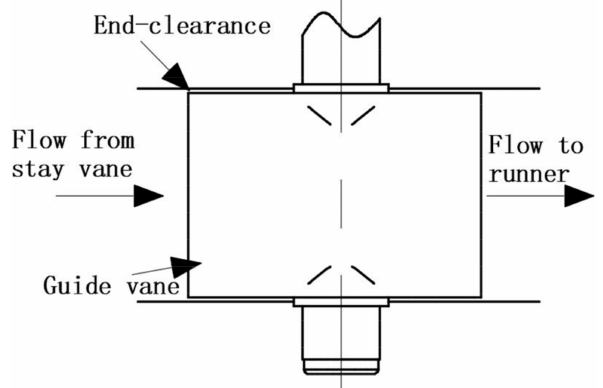
Figure 2. Schematic diagram of end-clearance of the guide